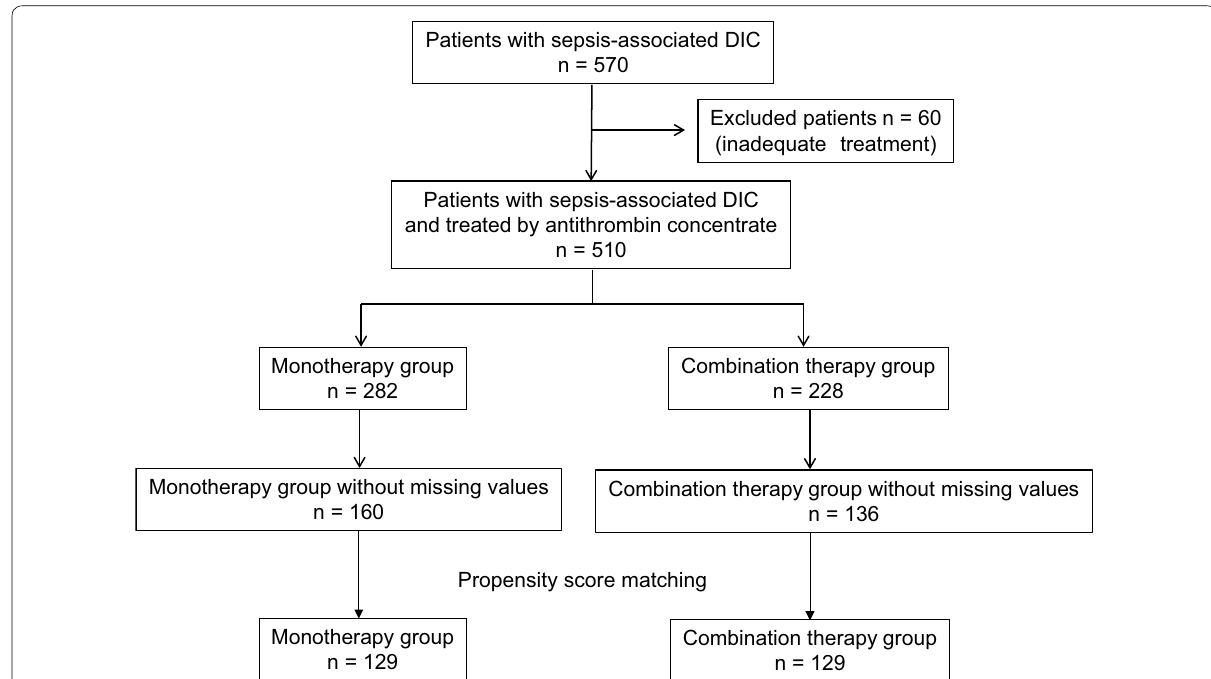
Fig. 1 Patient selection for the evaluation of antithrombin concentrate and recombinant thrombomodulin combination therapy. DIC disseminated intravascular